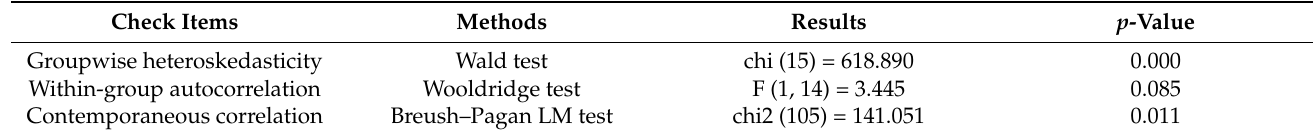
Table 5. Panel data check results.